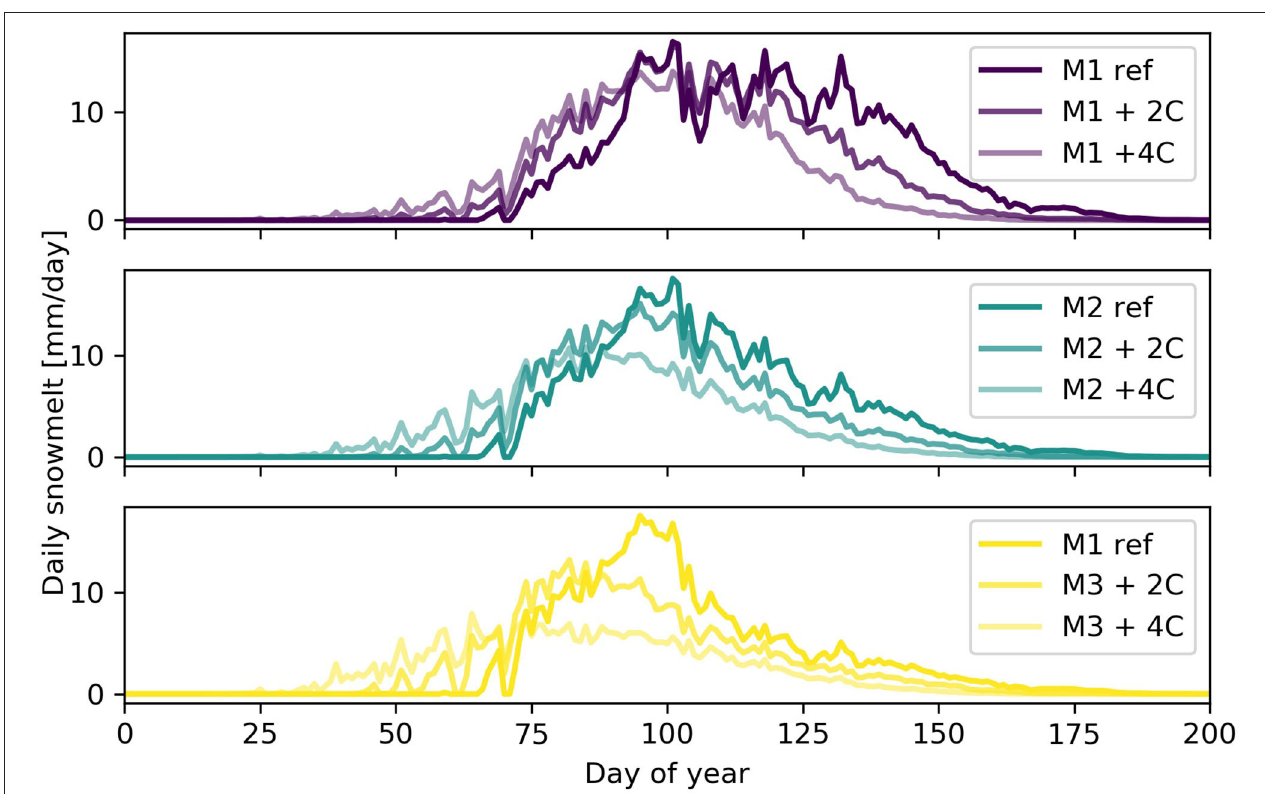
FIGURE 11 | Daily snowmelt rates for three idealized hypsometries: M1 (top), M2, and M3 (bottom) and two temperature scenarios.